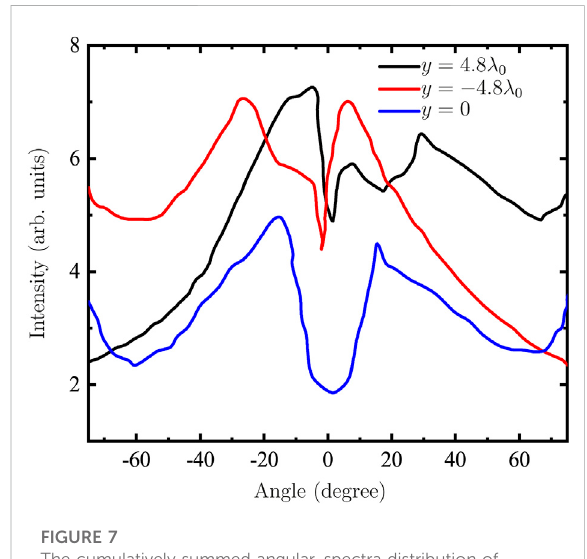
FIGURE 7 The cumulatively summed angular-spectra distribution of THz radiation for the y = 4.8 λ 0 , y = − 4.8 λ 0 and y =